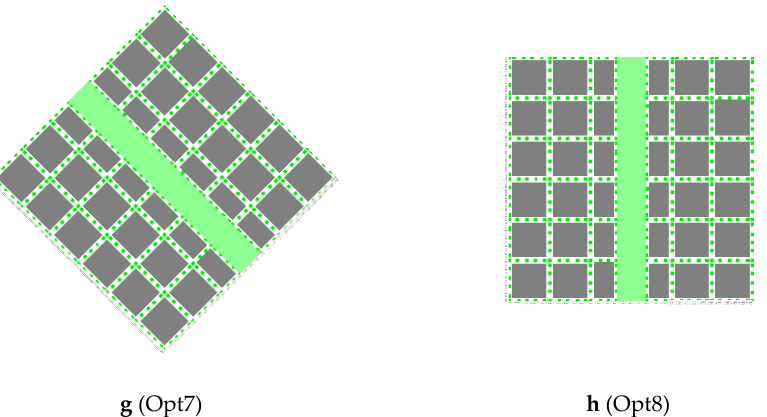
Figure 14. ( a – h ): Modeled in ENVI-met, primitive urban form compositions by fabric ( A c × n f = D c ), A s , A g and trees. ( a ) Fabric with concentric green spots. ( b ) Same as ( a ) but with 45° orientation. ( c ) Fabric with centric green spot. ( d ) Same as ( c ) but with 45° orientation. ( e ) Fabric with green avenue. ( f ) Same as ( e ) but with 45° orientation. ( g ) Same as ( e ) but with 315° orientation. ( h ) Same as ( e ) but with 270° orientation.